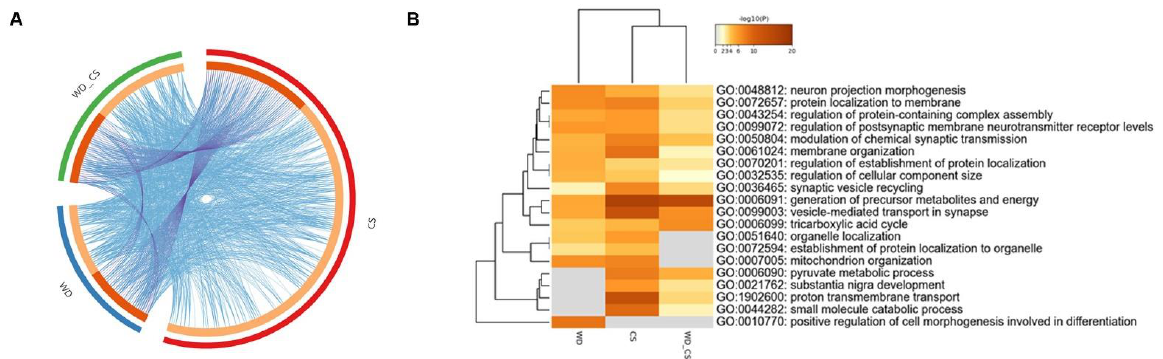
Figure 3. Enriched terms identified for proteins that were significantly different in the WD and CS/WD groups (both in comparison to CTR), filtered and hierarchically clustered (Metascape). ( A ) The circos plot shows how genes from the input gene lists overlap. On the outside, each arc represents the identity of each gene list (blue: WD; red: CS; green: WD/CS). On the inside, each arc represents a gene list, where each gene has a spot on the arc. Dark orange color represents the genes that appear in multiple lists, and light orange color represents genes that are unique to that gene list. Purple lines link the same genes that are shared by multiple gene lists. Blue lines link the different genes where they fall into the same ontology term (Metascape). ( B ) Enriched terms (Biological processes, GO: BP) identified for proteins that were significantly different in the WD, CS, and WD/CS groups (all in comparison to CTR), filtered, and hierarchically clustered (Metascape).